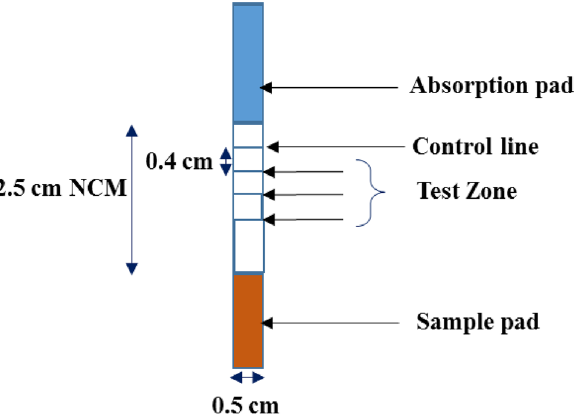
Figure 2. Schematic representation of lateral flow assay strip preparation. The figure describes a single strip of LFA with the width of 0.5 cm; length of NCM 2.5 cm and location of control line at the top and three test lines 0.4 cm below